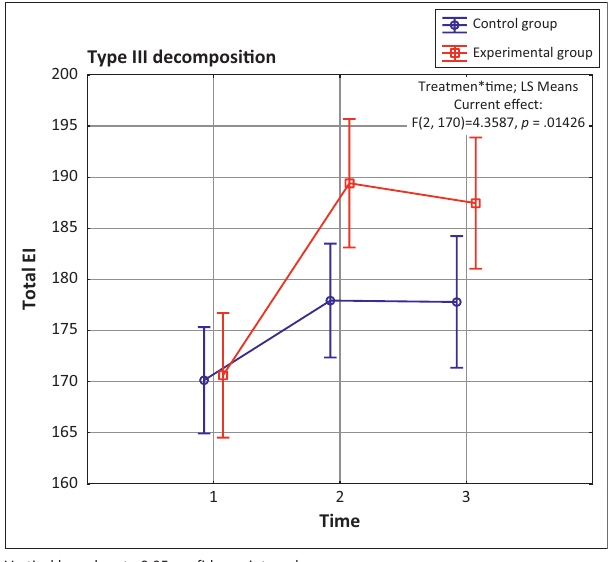
Vertical bars denote 0.95 confidence intervals. FIGURE 1: Time-by-group interaction: Emotional